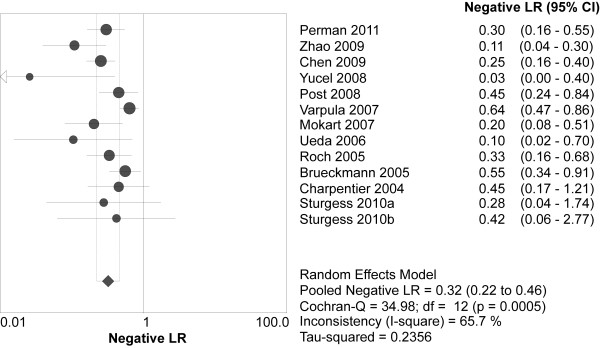
Summary of the negative likelihood ratio of elevated BNP or NT-proBNP in predicting mortality. BNP = brain natriuretic peptide, NT-proBNP = N-terminal pro-B-type natriuretic peptide.